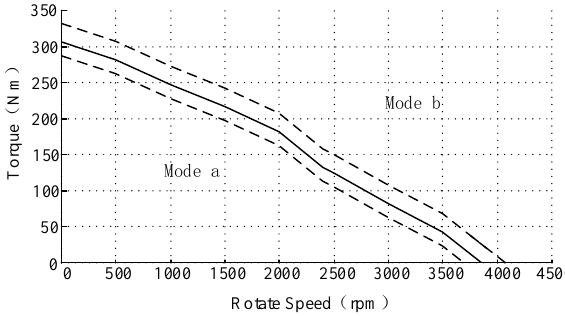
Figure 4. Switching boundary of two working modes under hysteresis control.